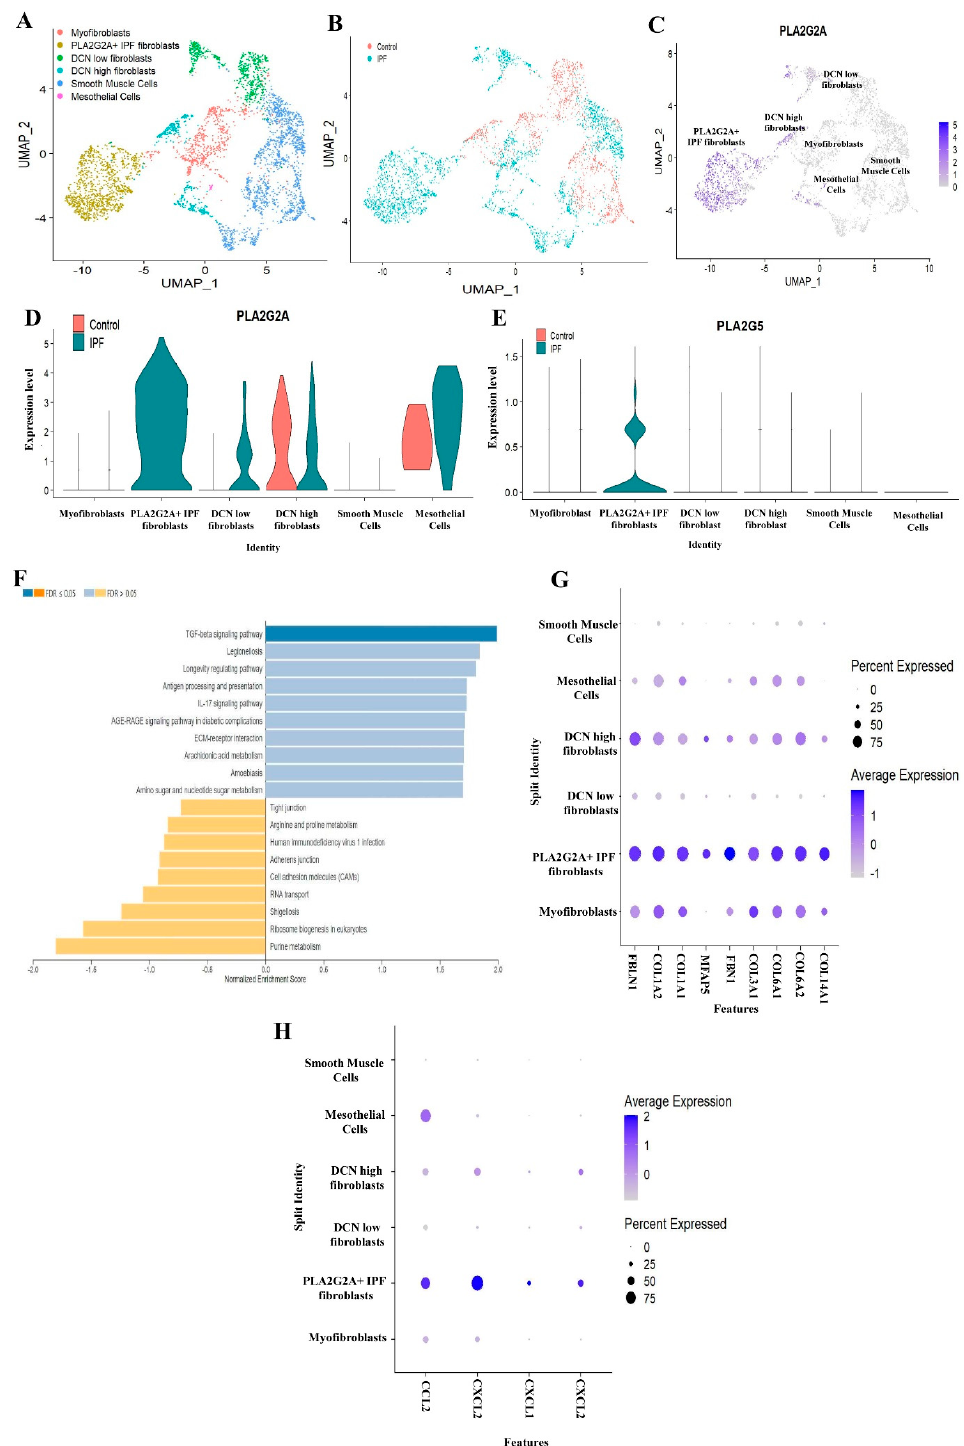
Figure 2. Analyzing expression of PLA2G2A and PLA2G5 in mesenchymal cells in data set A (GSE135893). ( A ) UMAP visualization of mesenchymal cells, various clusters displaying different types of mesenchymal cells. ( B ) UMAP plot showing cells, colored by their origin either from Control or IPF patients. ( C ) Feature plot displaying expression of PLA2G2A. ( D ) Violin plot showing expres- sion of PLA2G2A in various subclusters of mesenchymal cells. ( E ) Violin plot of expression of PLA2G5 in mesenchymal cells. ( F ) Enrichment analysis of pathways differentially regulated in PLA2G2A+ IPF fibroblasts. ( G ) DOT plot showing the upregulation of key ECM genes in mesenchymal cells. ( H ) DOT plot showing the upregulation of key inflammatory genes in mesenchymal